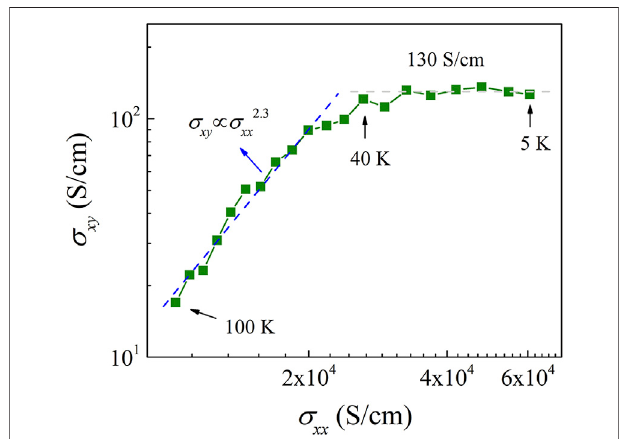
FIGURE 4 | The scaling relation between the anomalous Hall conductivity σ xy and the longitudinal conductivity σ xx .